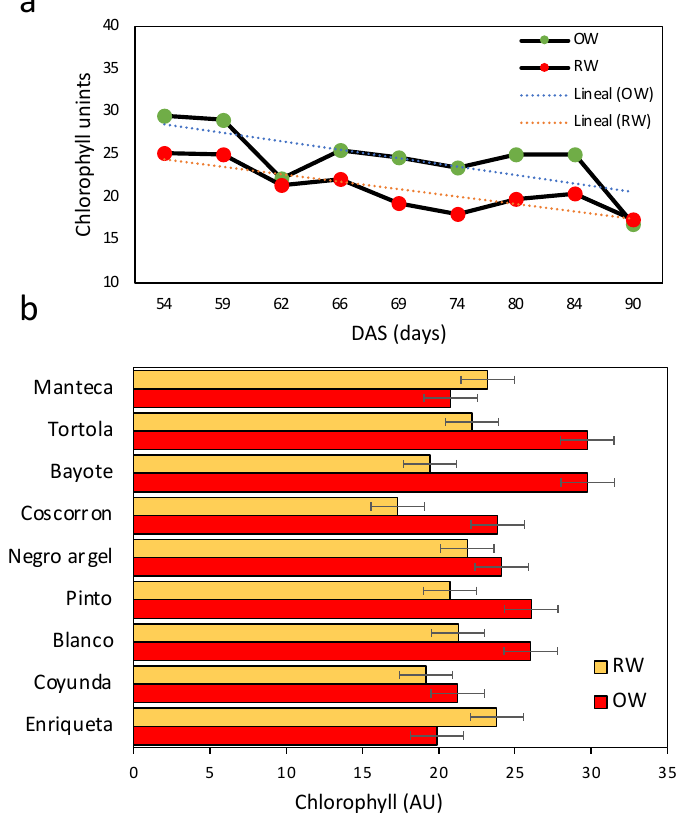
Figure 4. Effect of water stress on the concentration of leaf chlorophyll in common bean Chilean landraces. ( a ) Mean chlorophyll accumulation for nine common bean landraces under OW (green dot) and RW (red dot). ( b ) Chlorophyl accumulation in nine landraces under OW (red bars) and RW (orange bars). Bars represent the mean of 9 measurements during 54 – 90 DAS. Error bars represent least significant differences (LSD) value of the interaction water conditions by varieties at p < 0.05.